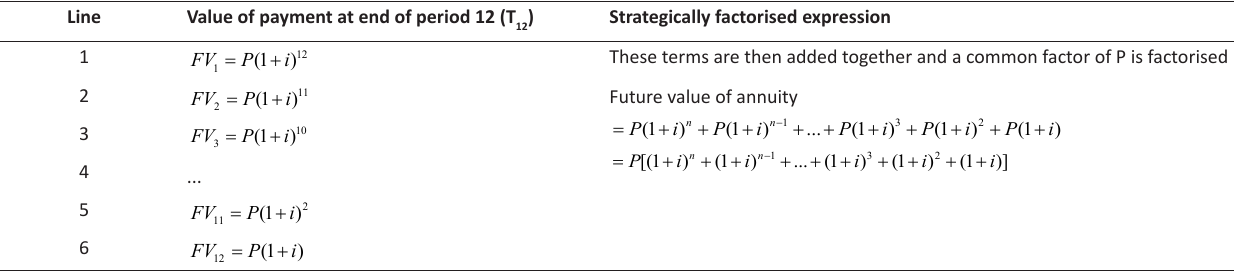
FIGURE 4: Individual payment approach to generate series for future value of annuity